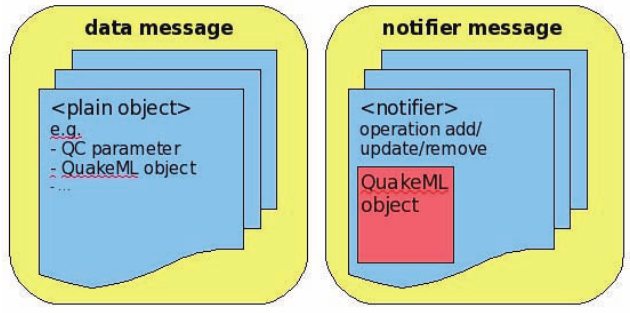
Figure 3. SeisComP3 schematic data and notifier